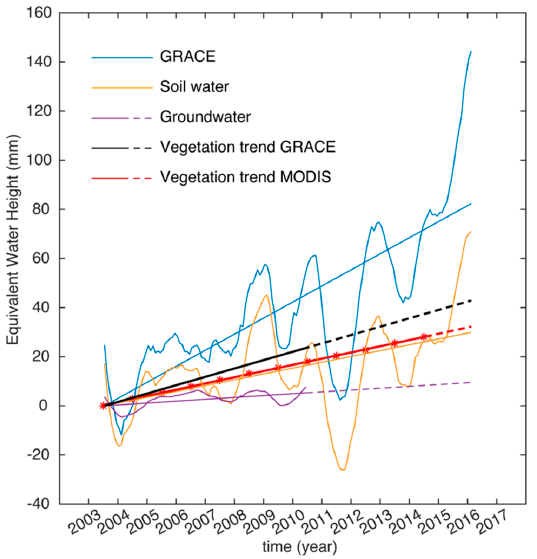
Figure 4. The time series and their corresponding linear change of each factor after a one-year filter. The dotted lines are the extension of trends. Table 1. Mass change rate of each factor within the study region.